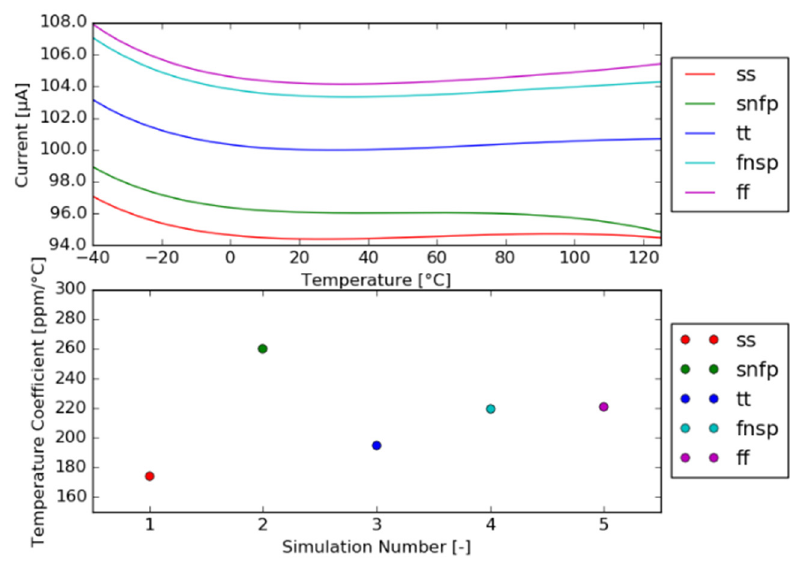
Figure 4. Process corner simulations of PCS output current.